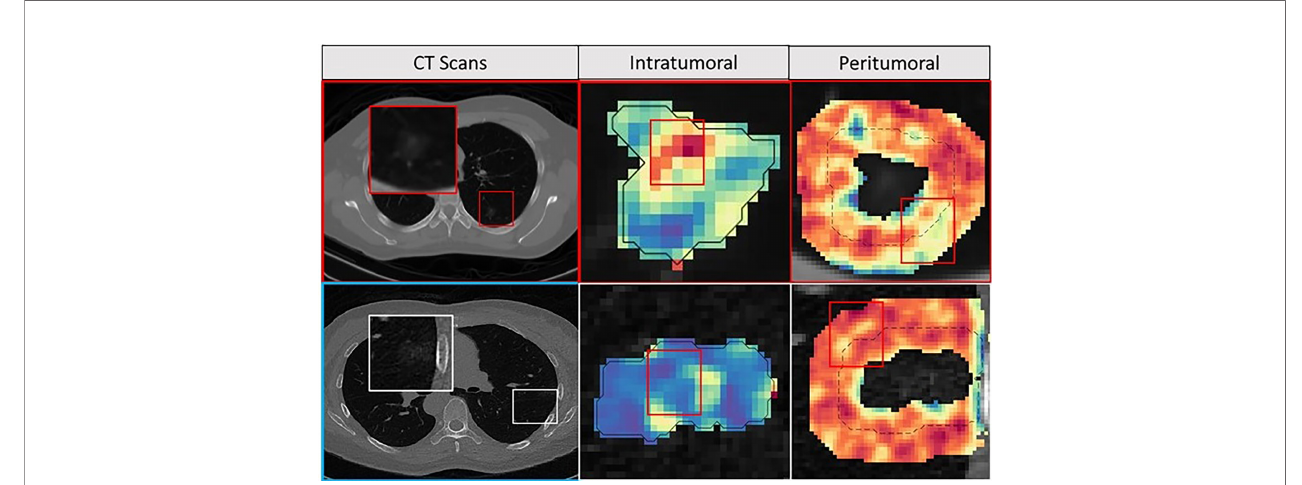
FIGURE 5 | Feature maps. The fi rst row depicts INV patient, and the bottom row depicts an MIA patient with an axial CT image as well as corresponding peritumoral and intratumoral feature maps. For the INV case, the feature maps had a higher feature expression compared to the MIA cases suggesting association between chaotic/disturbed microarchitecture and tumor invasiveness.